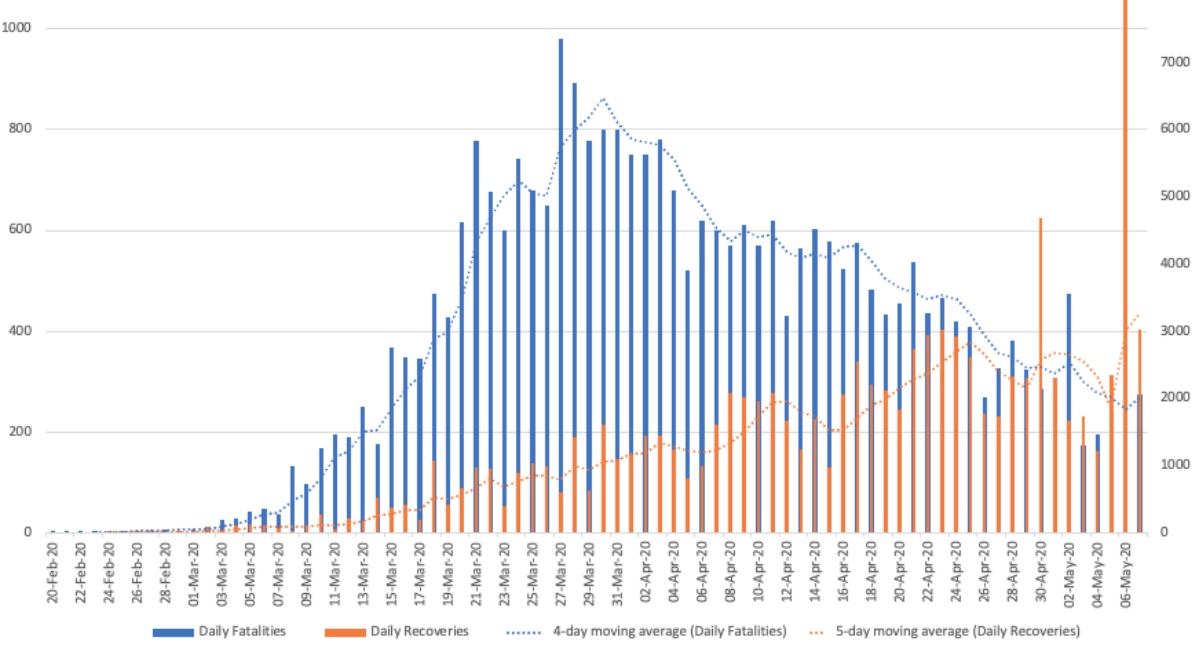
Figure 1. Graphical plot of COVID-19 daily fatalities versus recoveries in Italy. COVID-19: coronavirus disease.